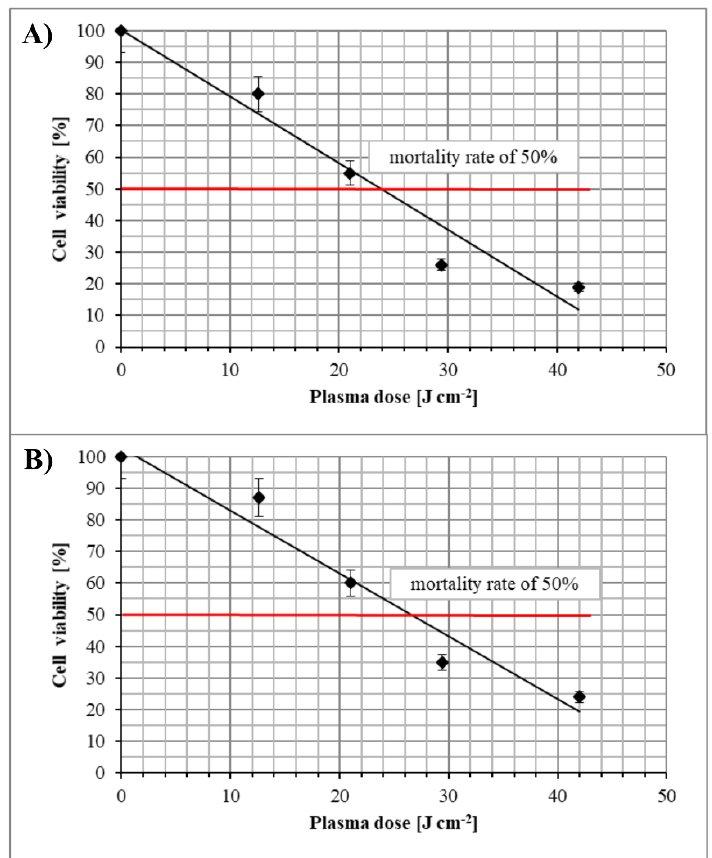
Figure 5. The effect of nonthermal plasma on the destruction of viable microbial cells forming fouling after 24-h contact of the activated sludge with: ( A ) polyamide membrane (PA); ( B ) cellulose acetate membrane (CA).